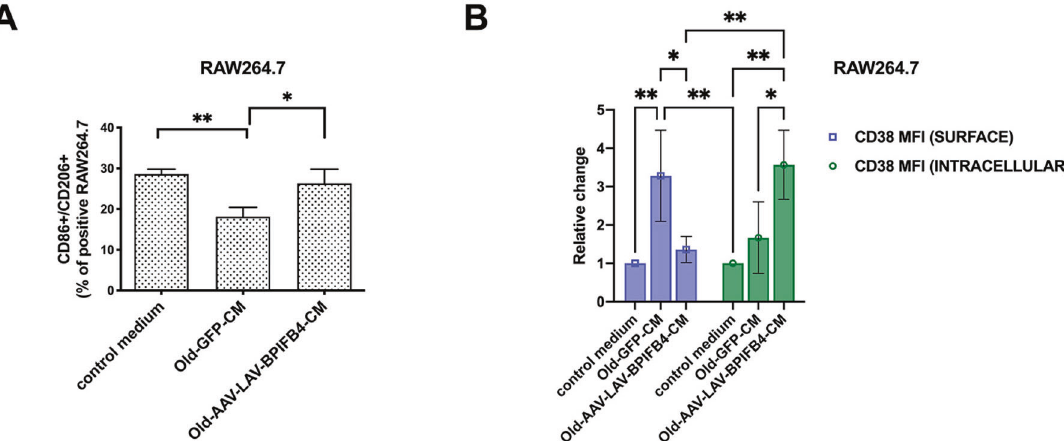
Fig. 4 Polarizing effects of AAV-LAV-BPIFB4 splenic milieu on RAW264.7 macrophages in vitro. A Analysis of fl ow cytometry displays the percentage of CD86 + CD206 + M2 macrophages in RAW264.7 cells after 24 h treatment with Old-GFP and Old-AAV-LAV-BPIFB4 splenocytes conditioning media. Results are expressed as mean with SD. Pairwise comparisons statistically signi fi cant are indicated (* P < 0.05, ** P < 0.01). Statistical evaluation was carried out by ordinary one-way ANOVA corrected for Tukey ’ s multiple comparisons test (GraphPad ® Prism). B Histogram shows the mean fl uorescent intensity of both surface and intracellular CD38 expression on RAW264.7 cells exposed to splenocytes conditioned media for 24 h. Results are expressed as mean ± SD. Pairwise comparisons statistically signi fi cant are indicated (** P < 0.01, ** P < 0.01). Statistical evaluation was carried out by ordinary 2-way ANOVA corrected for Š ídák ’ s multiple comparisons test (GraphPad ® Prism).